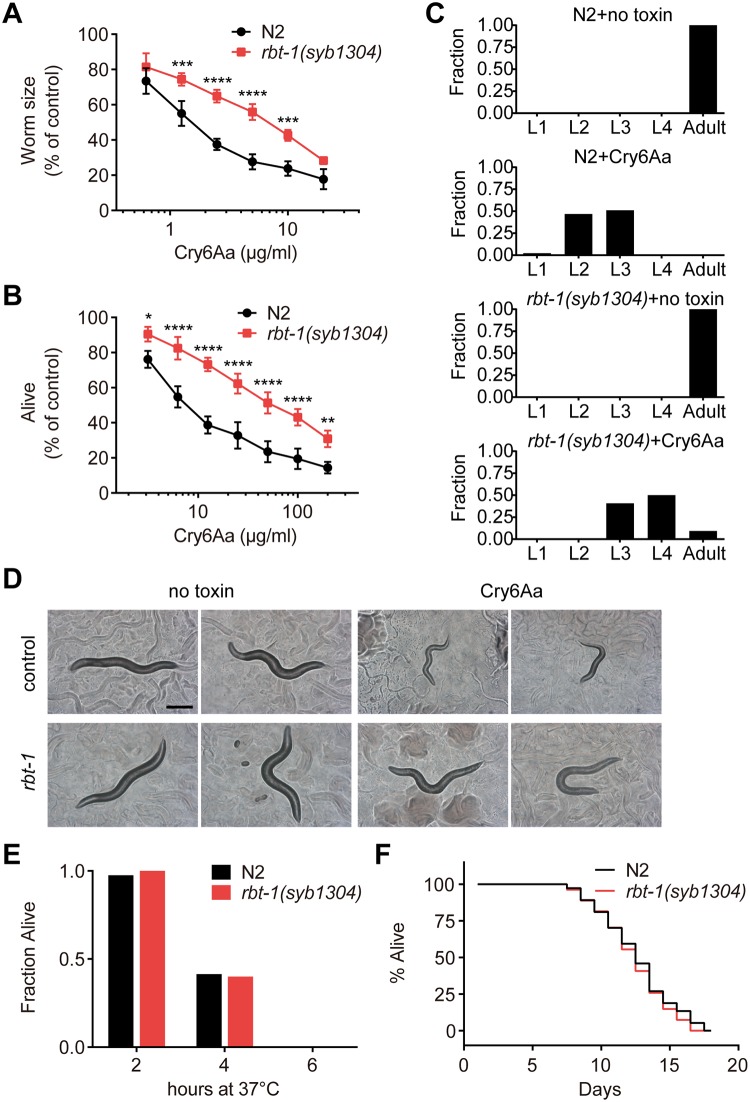
RBT-1 is involved in Cry6Aa toxicity against C. elegans.Dose-dependent growth assay (A) and mortality assay (B) were performed using Cry6Aa to quantitatively compare the sensitivities of wild-type N2 to mutant rbt-1(syb1304) worms. Both assays showed rbt-1(syb1304) reduced the susceptibility to Cry6Aa compared with N2. Values are means ± SD (n = 3 independent trials). Asterisks represent significant differences (n = 100 animals; *P < 0.05, **P < 0.01, ***P < 0.001 and ****P < 0.0001; two-way ANOVA). (C) A Cry6Aa development inhibition assay was performed with synchronized L1 stage worms of wild-type N2 to mutant rbt-1(syb1304). The animals were exposed to 20 μg/ml Cry6Aa. Developmental stages were assessed and presented as the percent of population reaching the indicated development stage after 3 days (without toxin) or 5 days (with Cry6Aa). Approximately 50 animals were used for each strain. (D) Toxicity assays using E. coli-expressed Cry6Aa on the plate to animals subjected to RNA interference assays. Wild-type N2 treated with RNAi empty vector (pL4440) or dsRNA for gene rbt-1 were transferred to plates containing the E. coli-expressed either Cry6Aa (Cry6Aa) or without toxin (no toxin) for 3 days. Reducing rbt-1 gene expression resulted in the reduced susceptibility to Cry6Aa. Two representative animals for each condition are shown. The experiment was performed in triplicate. Approximately 100 animals were used for each treatment. Scale bar, 200 μm. (E) A heat shock assay was used to compare the thermotolerance of wild-type N2 and mutant rbt-1(syb1304). The experiment was performed in triplicate. No differences were observed. (F) A lifespan assay. rbt-1(syb1304) showed similar lifespan to wild-type N2 at 25°C. Median survival was 13 days for both populations N2 and rbt-1(syb1304). Data were obtained from three independent experiments. On average, 30 animals were tested per data point.